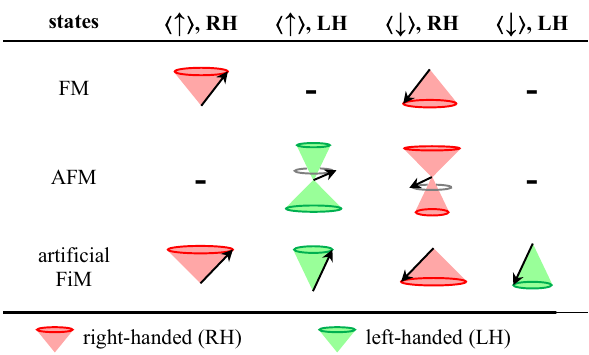
Fig. 4 FMR mode with left-handed (LH) chirality and exchange mode with right-handed (RH) chirality. a Normalized V / P app signals at T = 30 K. The FMR mode is observed when H < H twist, and the exchange mode is observed when H > H twist . b The dispersion relations between f and H res of the FMR mode and exchange mode at T = 30 K. The FMR mode is con fi rmed through fi tting by the Kittel equation. The H res dependence of f for the exchange mode is calculated by the micromagnetic simulation. c Normalized V / P app signals ( f = 16 GHz) at 20 K, 30 K and 40 K. FMR mode (exchange mode) is indicated by green (red) arrows. Gray dotted lines indicate the strength of H twist . d The recurrent switching of the external fi eld H can modulate ( e ) the chirality as well as the V ( H ) signal. The change of H ( Δ H ) for this modulation can be reduced by decreasing H twist , as shown in the inset of d .